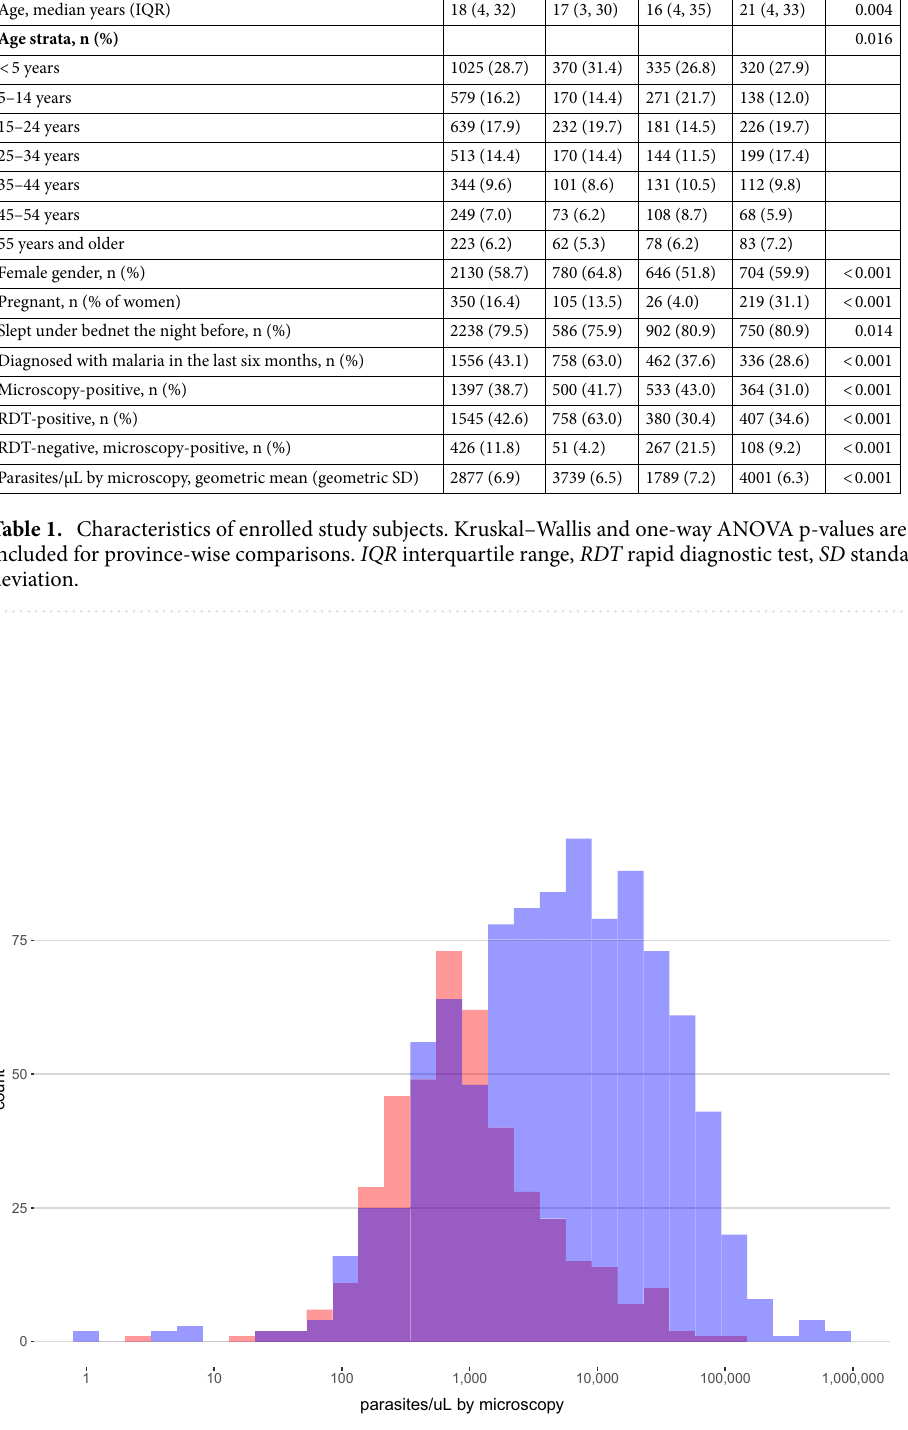
Figure 2. Parasite densities by microscopy among HRP2-based RDT-negative (red) and RDT-positive (blue) isolates. False-negative RDT results were more likely to occur at low microscopy parasite densities, with geometric means of 959 (geometric standard deviation [SD] 4.2) and 4675 (geom. SD 6.9) parasites/µL for RDT- negative versus RDT-positive samples, respectively (t-test p < 0.001). RDT rapid diagnostic